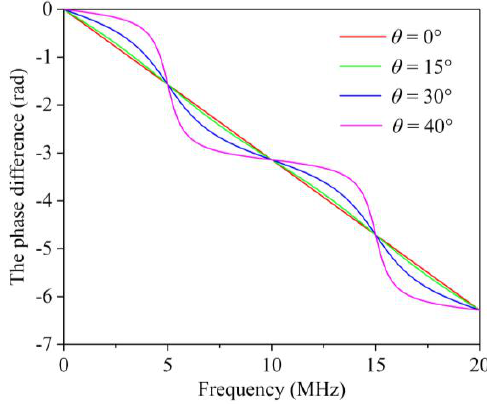
Figure 1. Functional image of the phase difference.